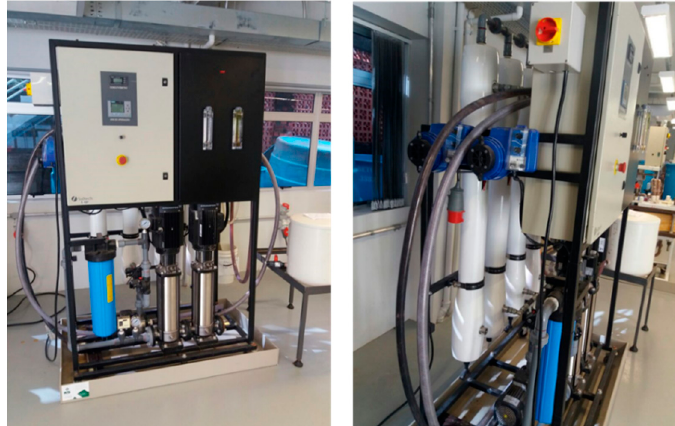
Figure 1. Reverse osmosis (RO) pilot system (PAM Selective Membranes, Rio de Janeiro, Brazil) equipped by a spiral polyamide membrane module BW 30 (4040) (Filmtec, Dow Chemical, Midland, MI, USA) with a membrane area of 7.2 m 2 .